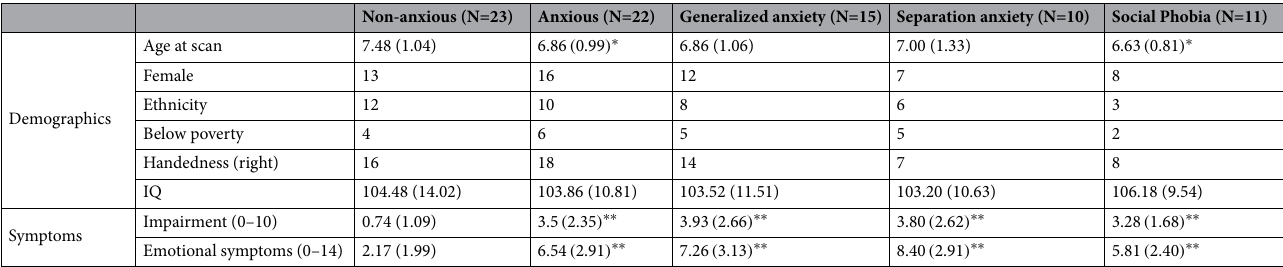
Table 1. A summary table of demographic and clinical symptom scores of participants. The anxious group contained individuals with one or more anxiety disorders from the mentioned subtypes. The 3 anxiety subtypes are not mutually exclusive. T-tests were conducted between the non-anxious group and all anxious subtypes, as well as the whole anxious group. Mean values and standard deviations are reported for all 4 ∗ p < 0.05 ∗∗ p < 0.005 groups. Significant difference from non-anxious children at ,